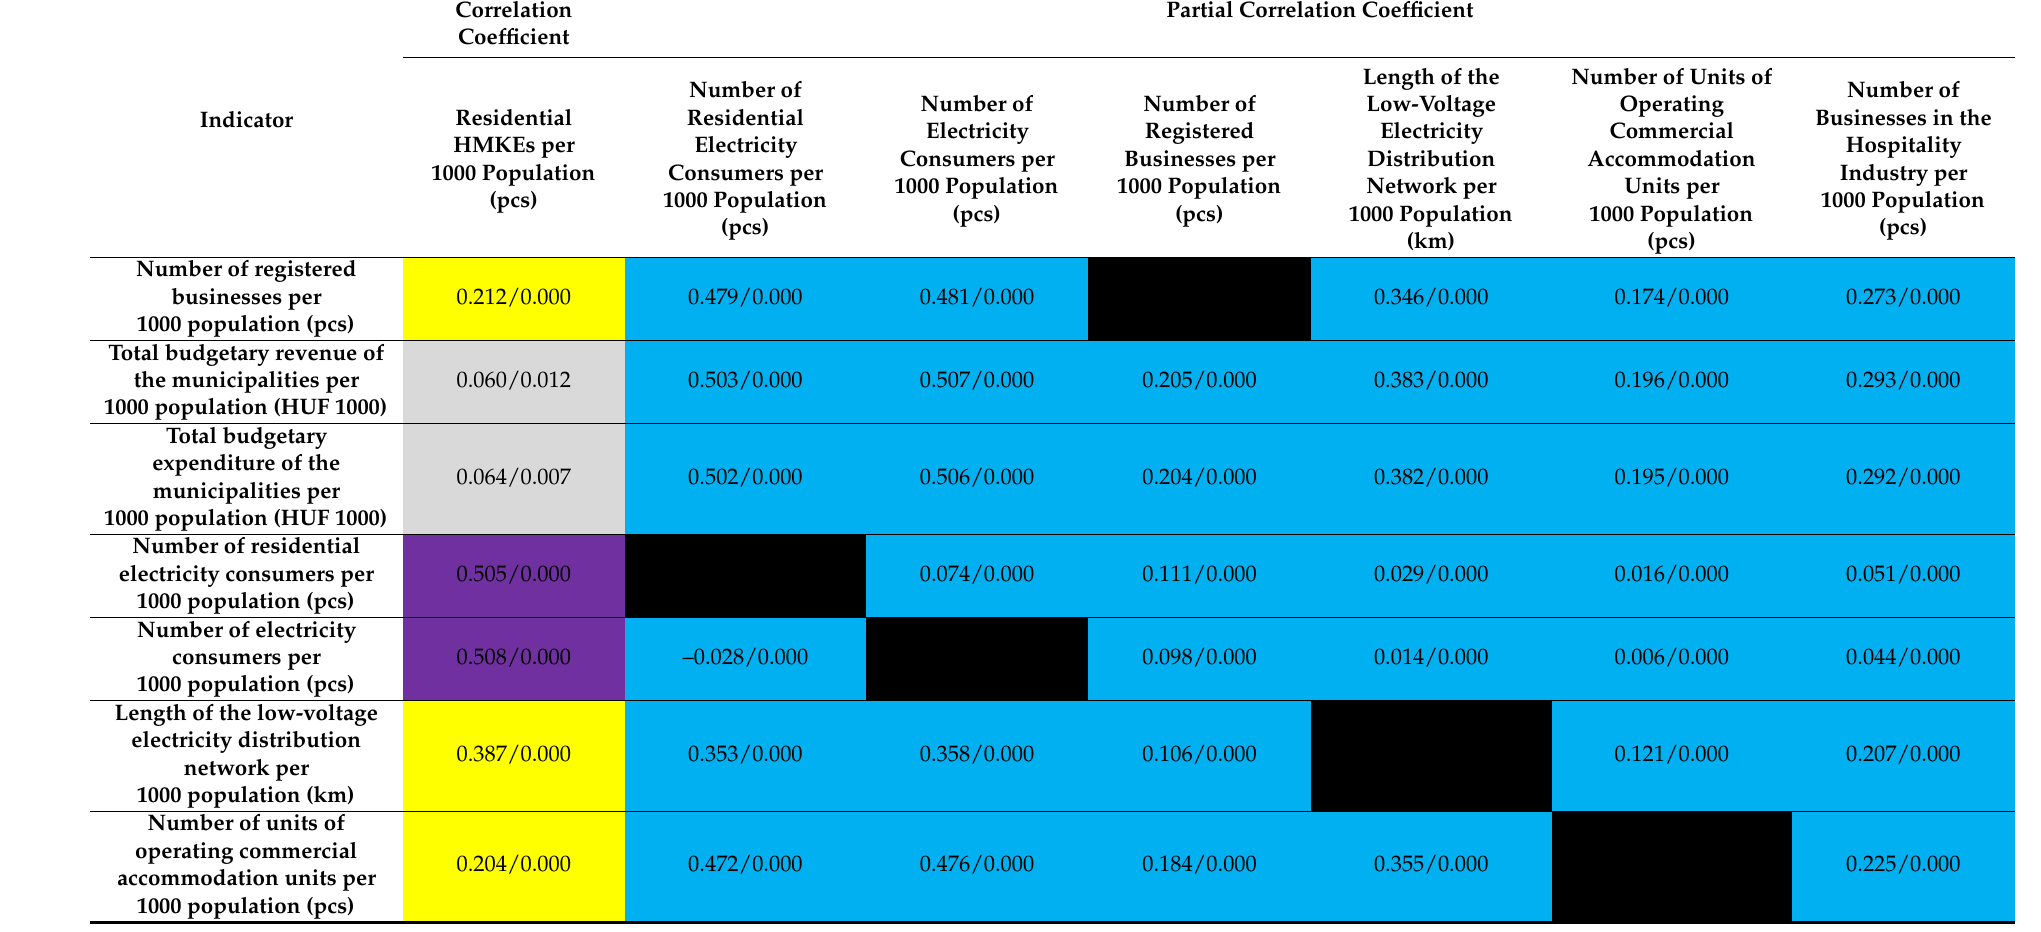
Table A5. The strengths of the relationships between the quantity of the residential HMKEs per 1000 population and the settlement indicators 1 ( 1 Pearson correlation coefficient/ p -value; if p < 0.05, then there is a significant verified relationship between the two variables) (In the case of the Pearson correlation coefficients in the table grey background indicates weak correlations, yellow means weak moderate, and purple moderately close ones. In the case of the partial correlation the blue background signals partial explanation (the controlled variable explains the relationship between variables i and j only partially), while the black one shows irrelevant